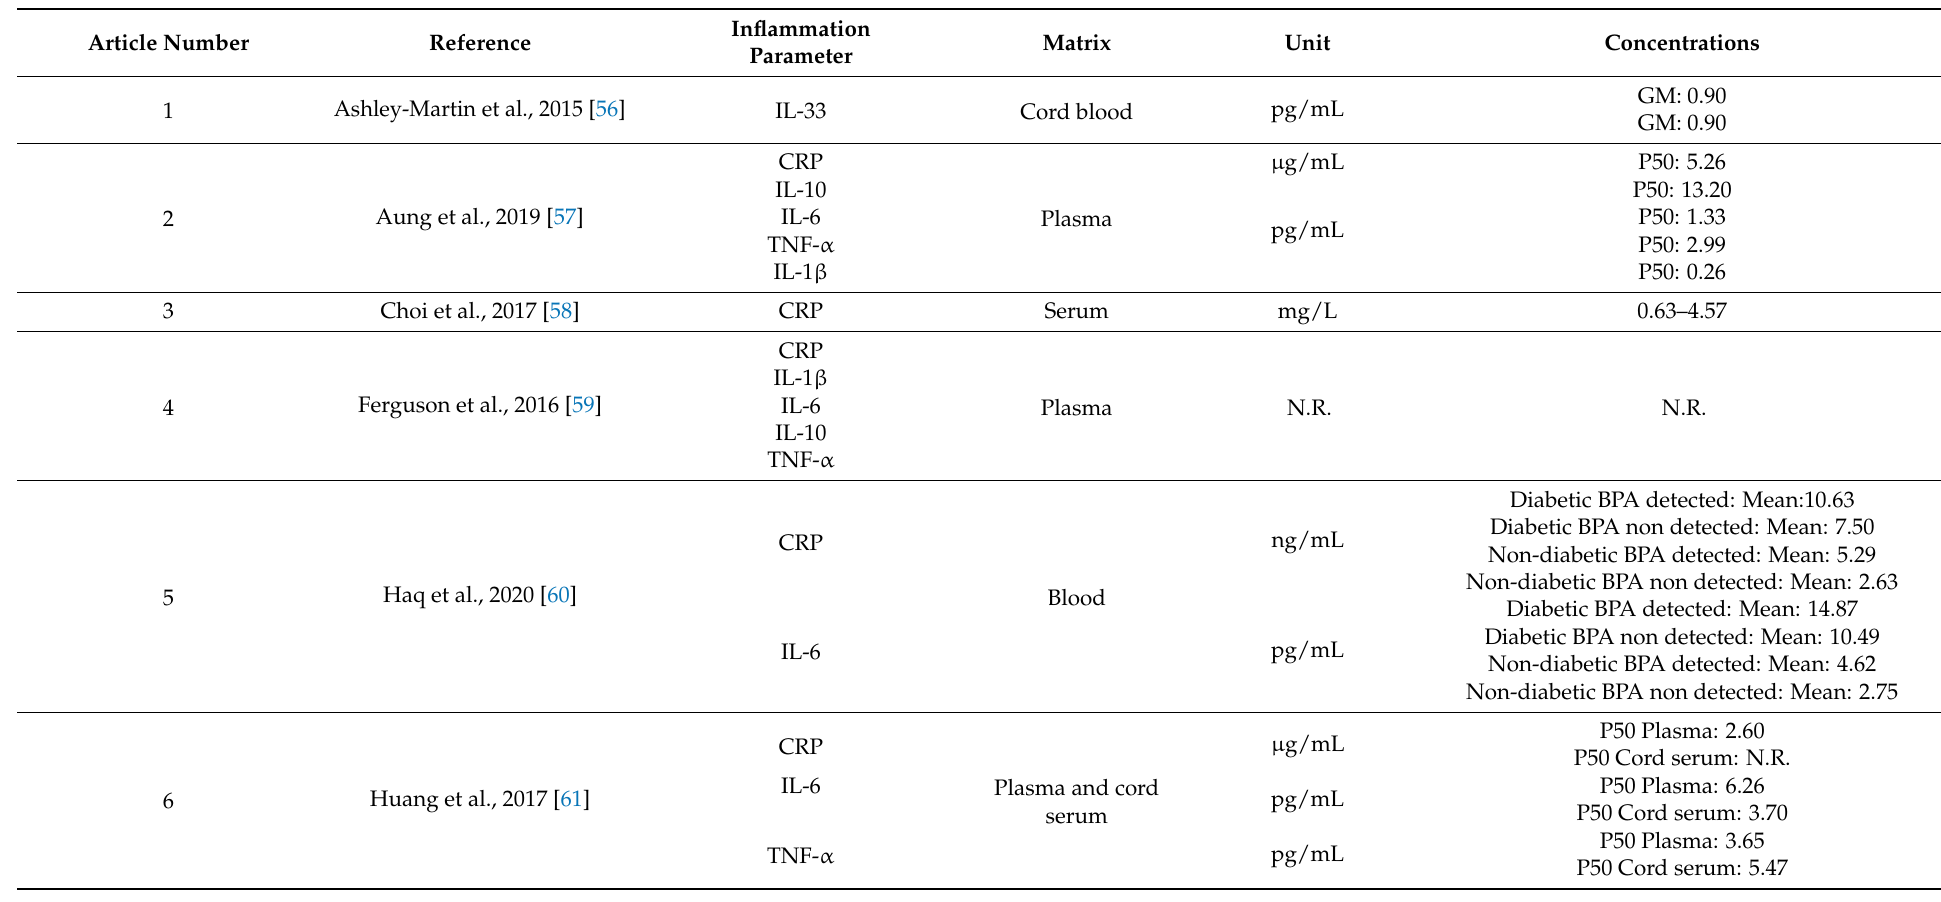
Table 3. Characteristics related to the outcome assessment in the selected